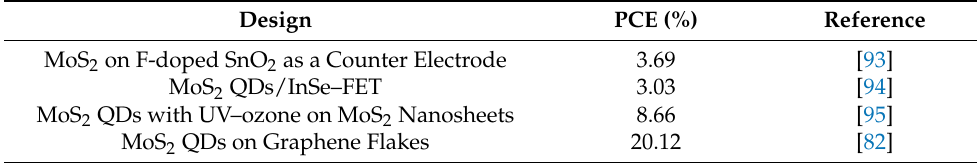
Table 4. Uses of MoS 2 QDs in solar cell technology and reported power conversion efficiencies.